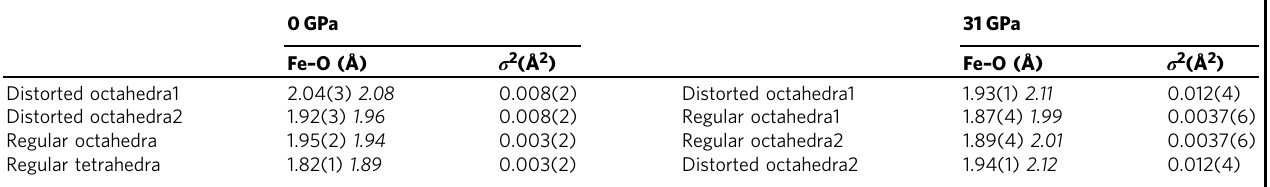
Table 2 Interatomic Fe – O bond lengths and Debye – Waller factors obtained by EXAFS analysis with uncertainties expressed in brackets. Ab initio theoretically simulated bond lengths are written in italics. The R -factor values of the fi t are 0.019 (0.013) for 0 GPa (31